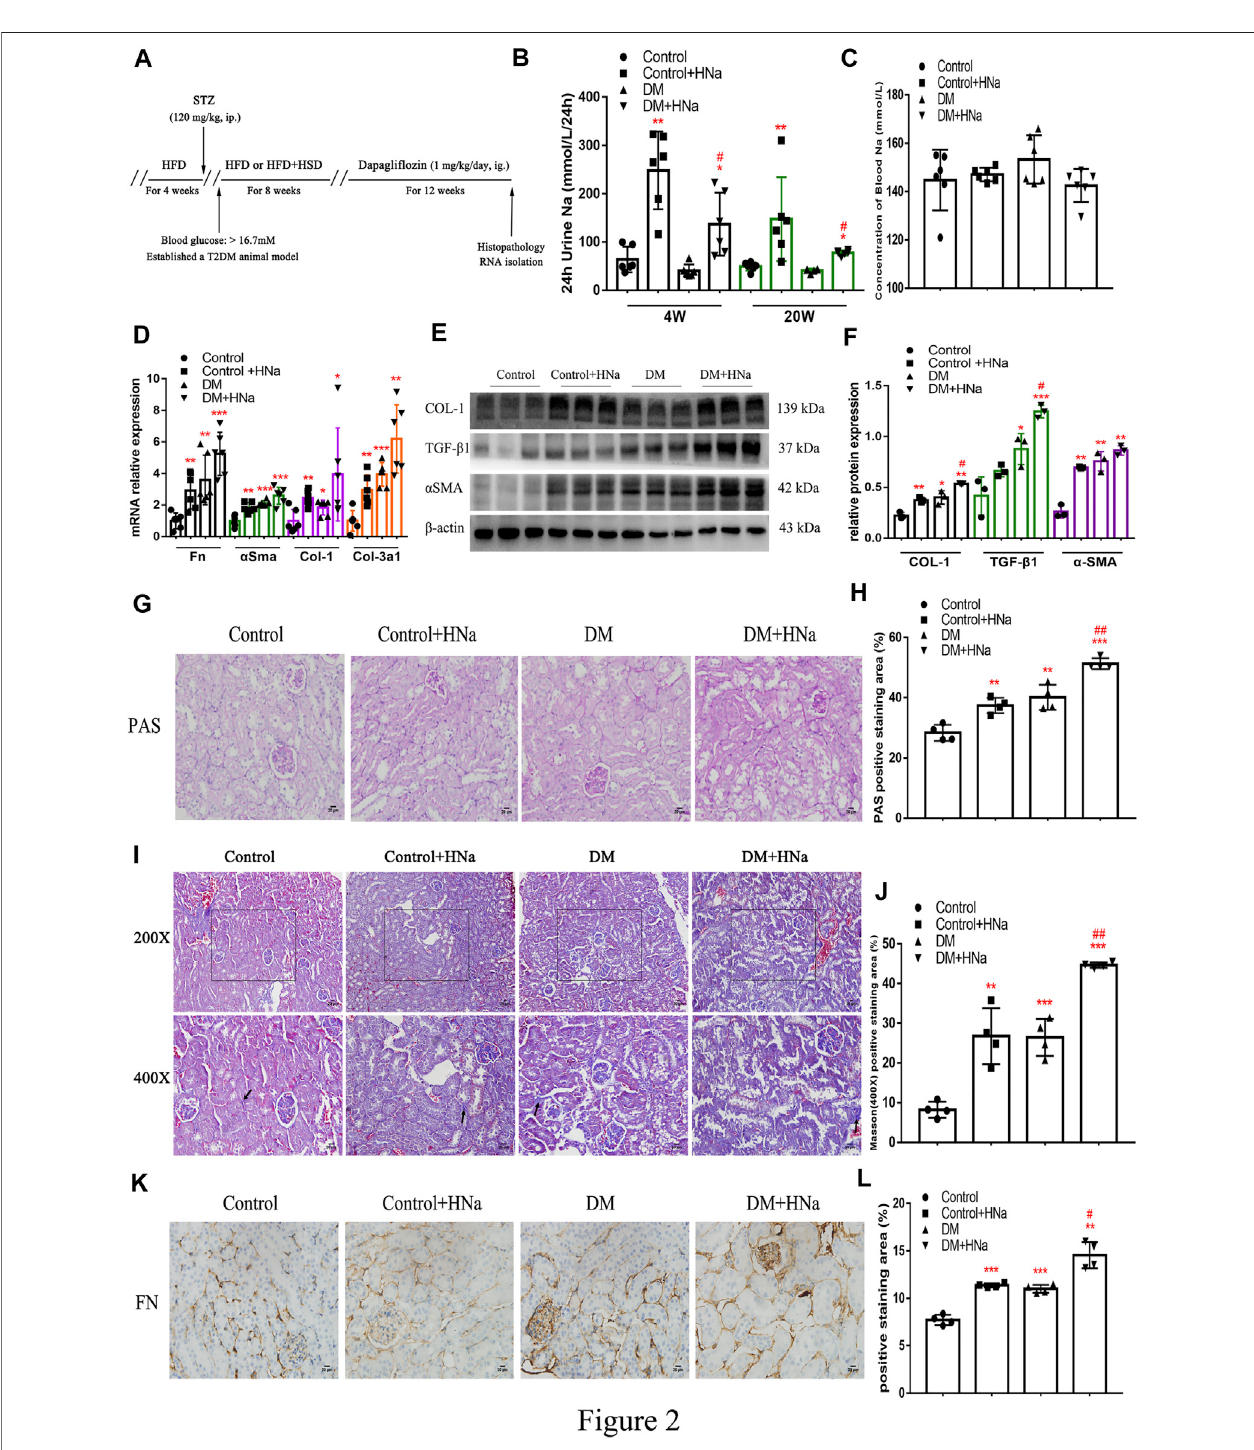
FIGURE2|| High-saltdietaggravatesrenal fi brosisindiabeticmice. (A) Schematicdiagramoftheexperimentplan.AfterHFDfor4 weeks,intraperitonealinjection of STZ was performed. One week later, blood glucose was detected and diabetic mice were selected to be fed with high-salt diet for 8 weeks, followed by dapagli fl ozin by gavage for 12 weeks. (B) 24 h urine Na wasmeasuredat 4 weeks and 20 weeks after high-saltdiet ( n (cid:1) 6per group). (C) Blood Na wasmeasured at 20 weeks after high-saltdiet ( n (cid:1) 6per group). (D) The levels of Fn, α Sma, Col-1 and Col-3a1 were detected byRT-qPCR( n (cid:1) 6per group). (E,F) Western Blot were performed to determinetheCOL-1,TGF- β 1and α SMAexpressionlevels( n (cid:1) 3pergroup). (G,H) PASstainingofparaf fi n-embeddedrenalsections(magni fi cation,400 × ,bar (cid:1) 20 μ m, n (cid:1) 4pergroup). (I,J) Masson ’ strichromestainingofparaf fi n-embeddedrenalsections(magni fi cation,400 × ,bar (cid:1) 20 μ m, n (cid:1) 4pergroup). (K,L) FNantibodystainingof paraf fi n-embedded kidney sections (magni fi cation, 400 × , bar (cid:1) 20 μ m, n (cid:1) 4 per group). All data are mean ± SEM, * p < 0.05, ** p < 0.01 and *** p < 0.001 vs. Control group; # p < 0.05 and ## p < 0.01 vs. DM group.